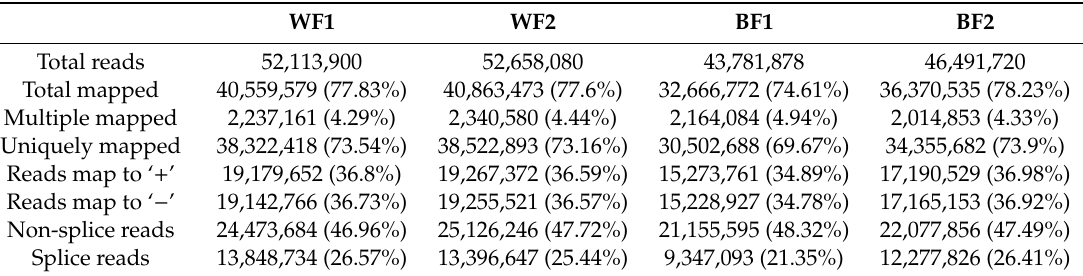
Table 1. Summary of mRNA-seq data.